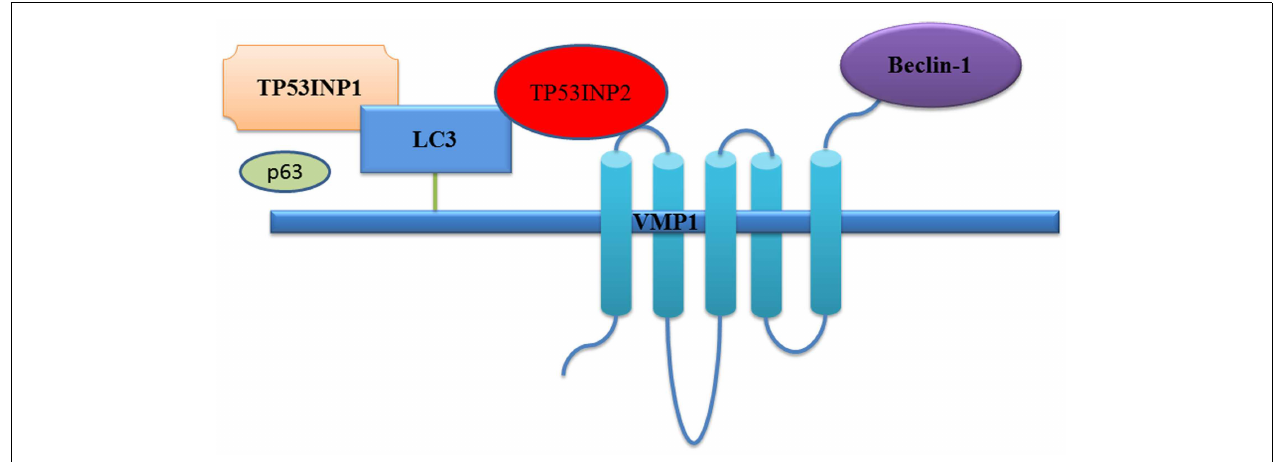
FIGURE 2 |TP53INP1 andTP53INP2 co-operatively induce autophagy . Under autophagy-inducing stress such as starvation,TP53INP2 translocates from the nucleus to the autophagosomes, interacts withVMP1, and